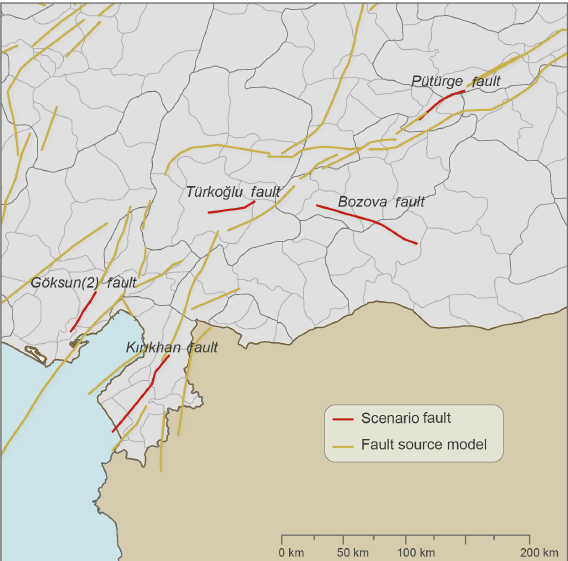
Figure 5. Fault locations selected for earthquake scenarios.